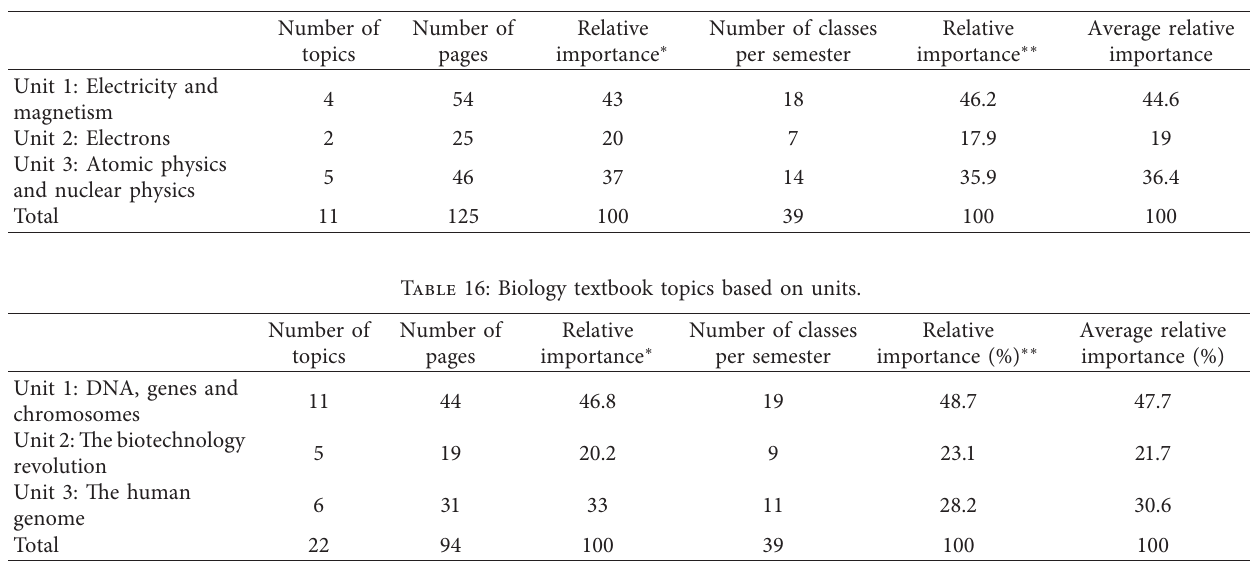
Table 15: Physics textbook topics based on units.